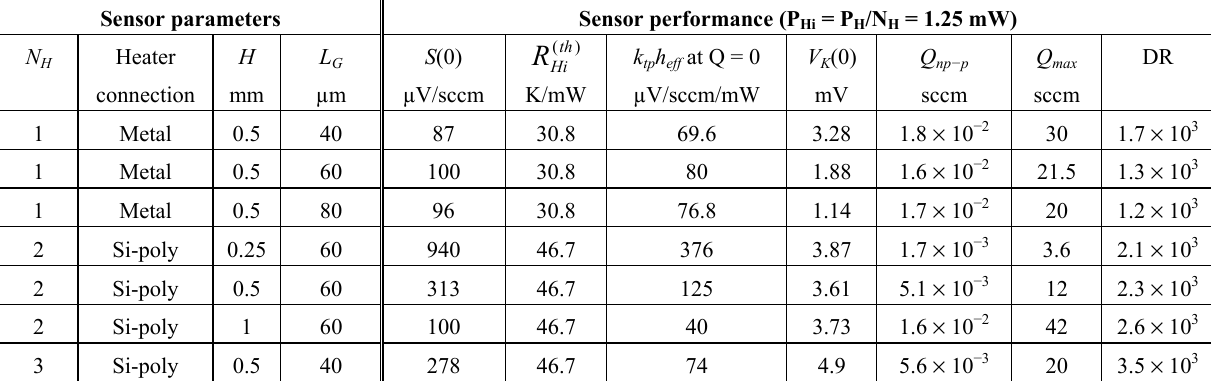
Table 2. Main parameters and performances of the sensors used in this work. The sensor resolution ( Q ) has been estimated considering a 100 Hz bandwidth. All figures refer to np − p nitrogen